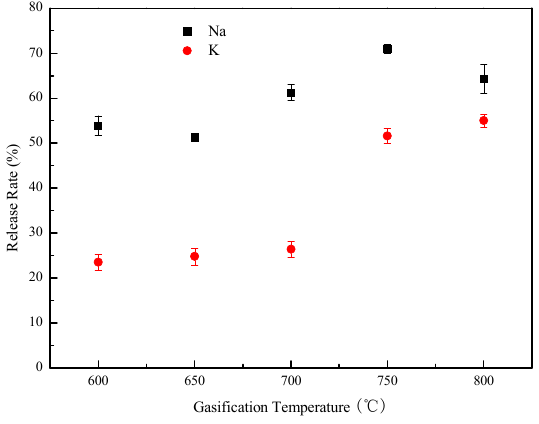
Figure 3. Variation of K and Na concentration in the gasification’s ash.